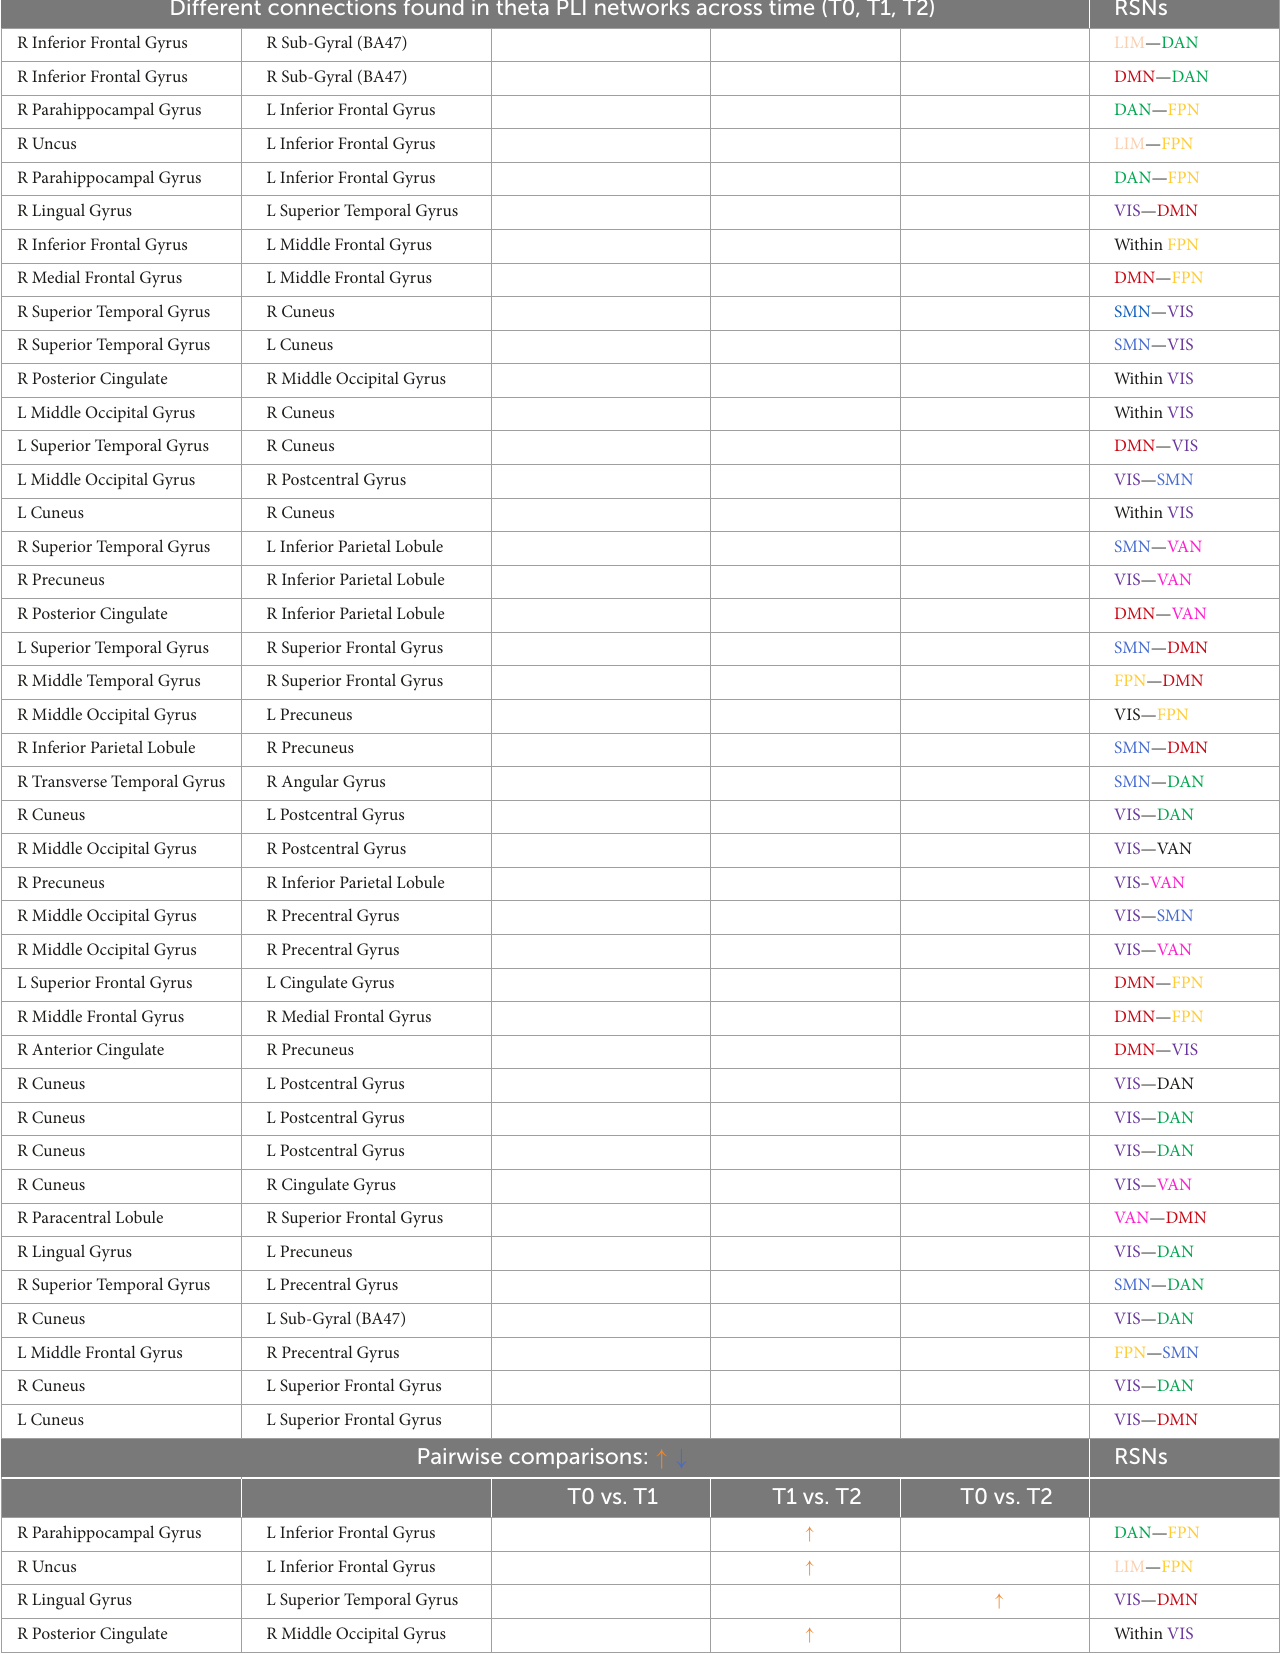
TABLE 2 Different connections found in theta PLI networks across time (T0, T1, T2) and after pairwise comparisons (L denotes left hemisphere; R denotes right hemisphere). Different connections found in theta PLI networks across time (T0, T1, T2)